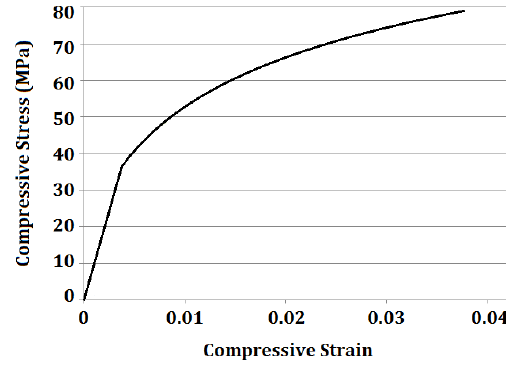
Figure 3. Stress‐strain curve for IG‐11. Figure 3. Stress-strain curve for IG-11. Table 1. Isotrpic plastic model